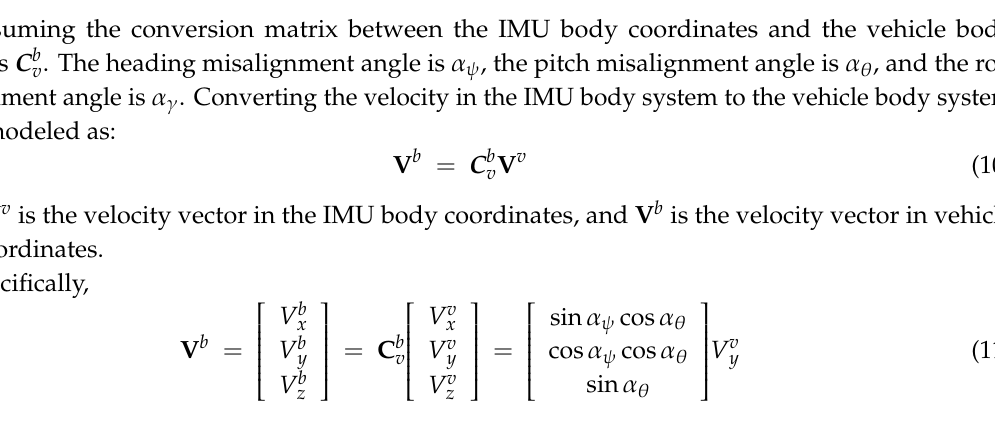
Figure 1. Illustration of the vehicle body coordinates.